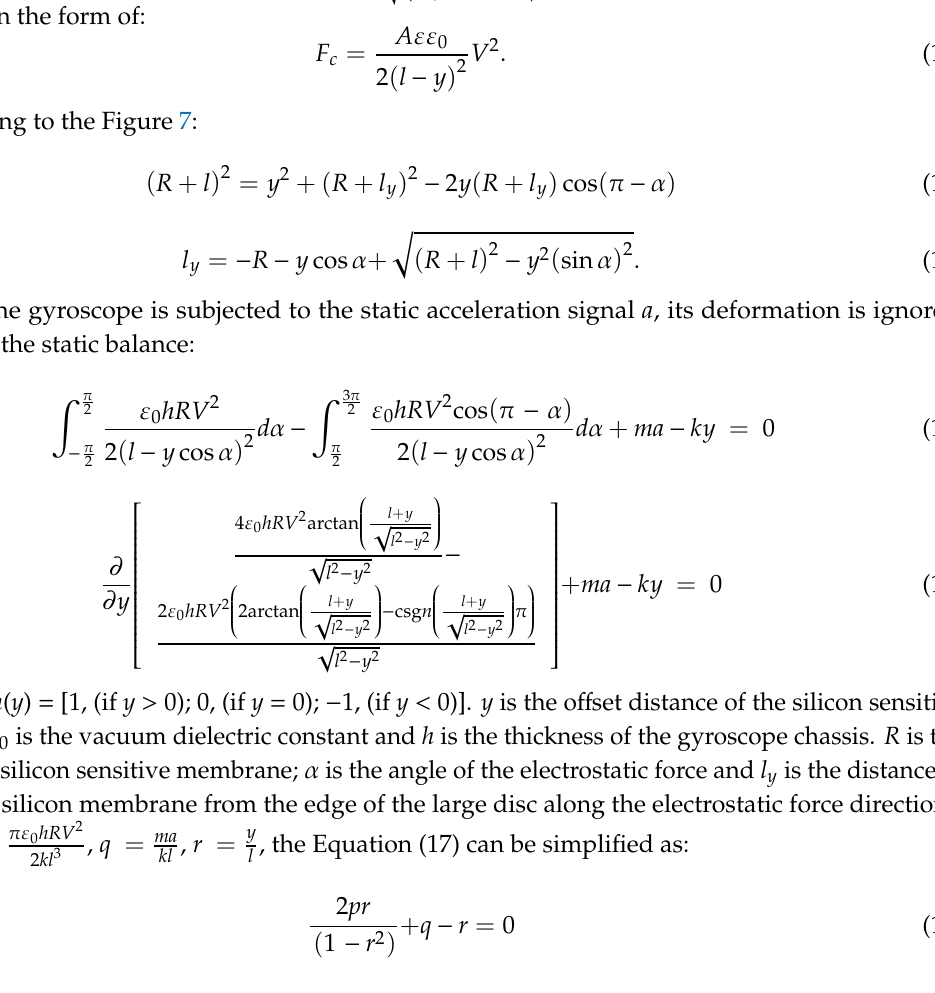
Figure 7. Schematic diagram of the force model of a rigid body.